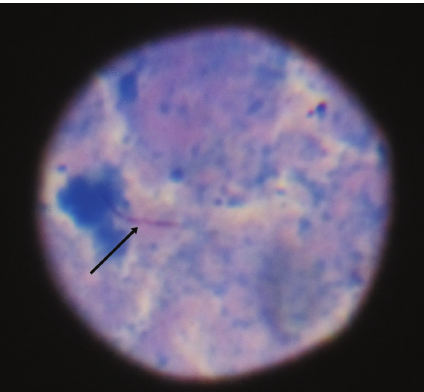
Figure 7: ZN stain of FNAC material from breast tissue with arrowhead showing acid fast